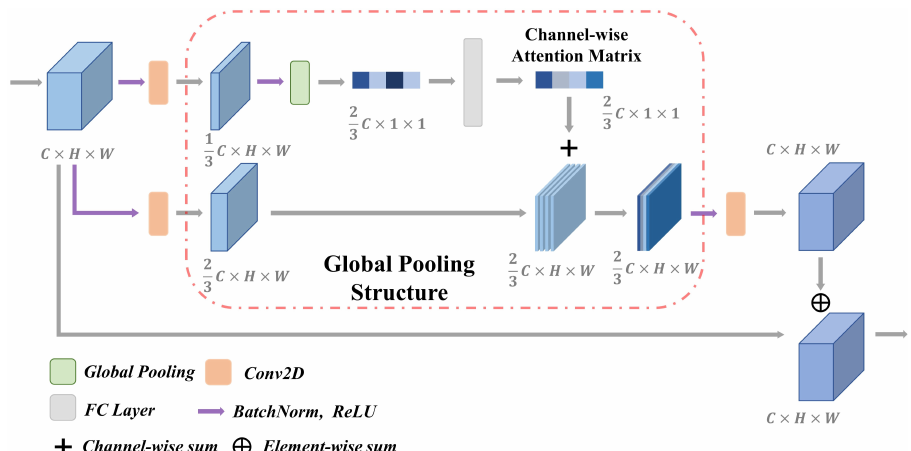
Figure 3. Proposed GARB. The structure globally aggregates values of one set of channels to bias another set of channels, potentially providing the final output with information on the global context in